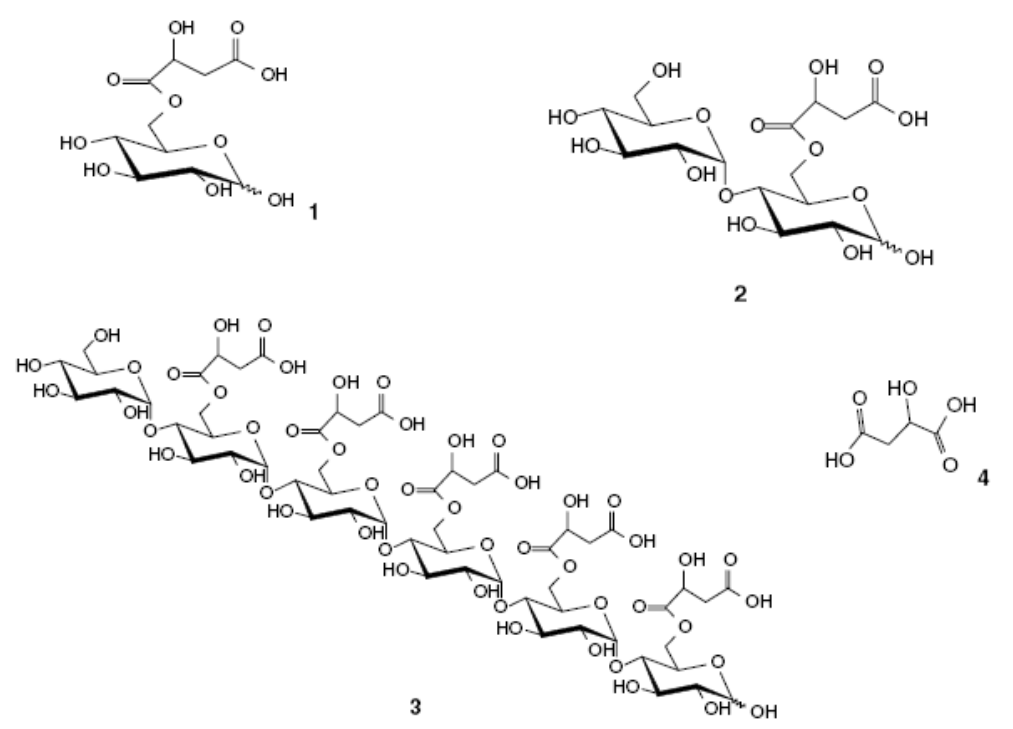
Figure 3. Chemical structures of veracylglucan A (1), veracylglucan B (2), veracylglucan C (3) and malic acid (4)